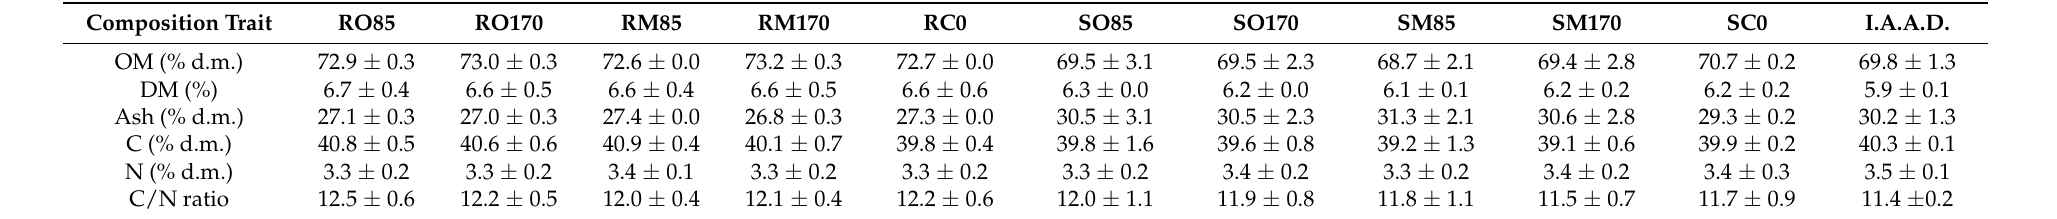
Table 6. Characteristics of digestate after anaerobic digestion from raw material and ensiled Helianthus salicifolius . Composition